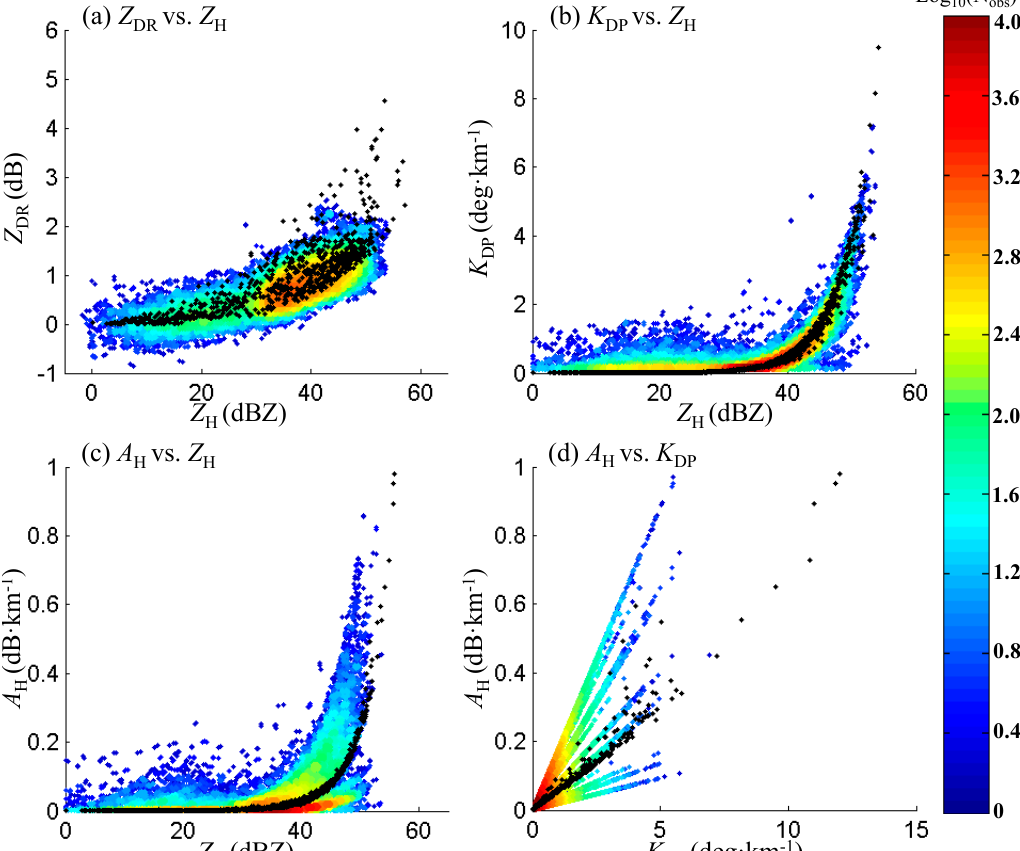
Figure 6. The scattergrams between different radar variables at a scan elevation angle of 0° at 0330 UTC on 1 June 2016: ( a ) Z DR vs. Z H ( b ) K DP vs. Z H ; ( c ) A H vs. Z H , ( d ) A H vs. K DP . The black dots stand for the simulated radar variables based on the drop size distribution measurements.